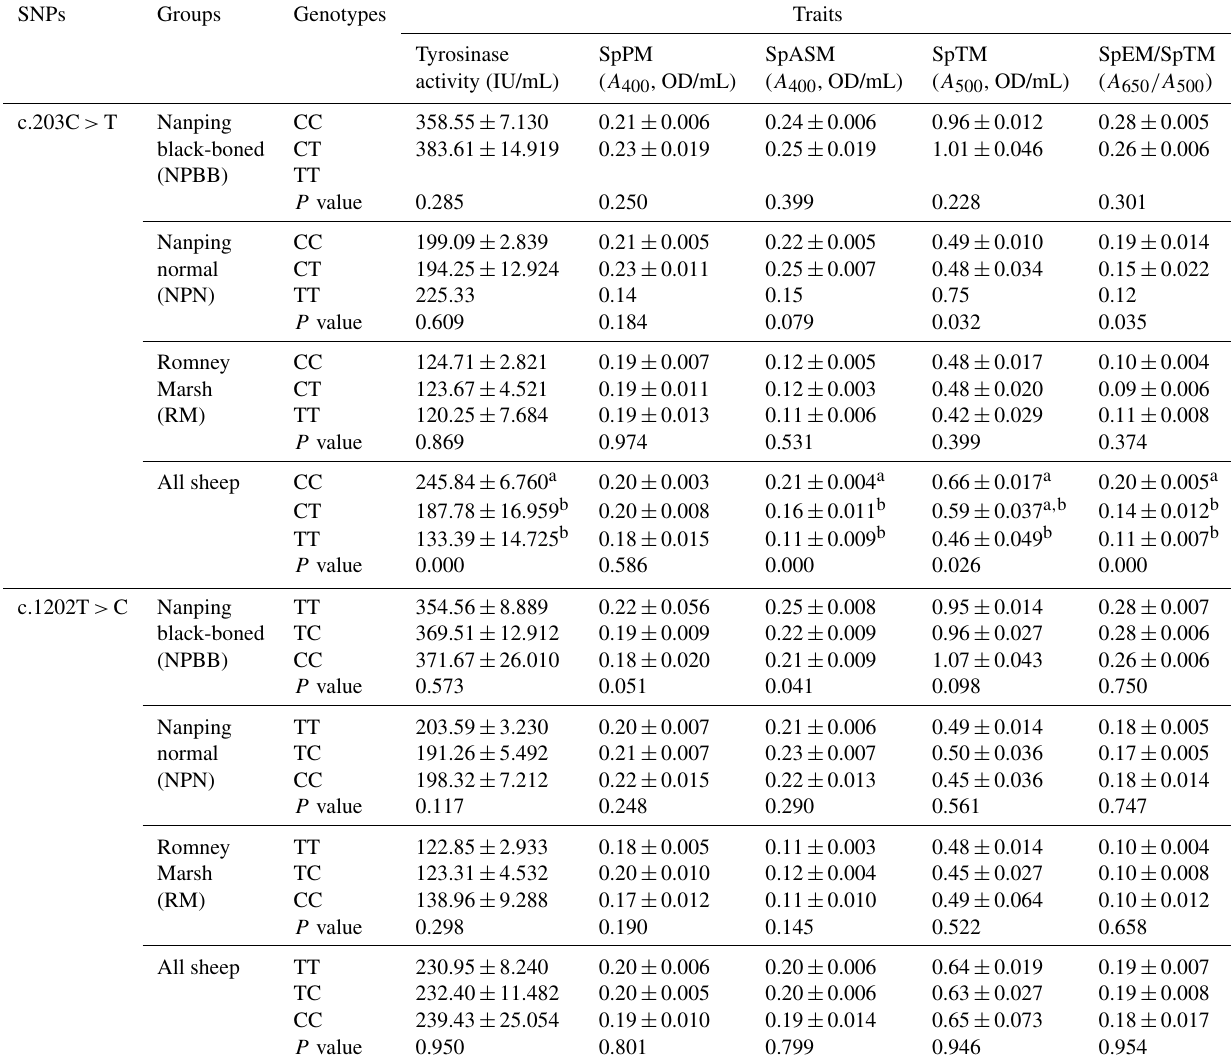
Table 2. Association analysis of the TYRP1 gene with black traits (least squares mean value ± 1SE; SE indicates the standard errors of the means) in the three flocks of sheep and all sheep